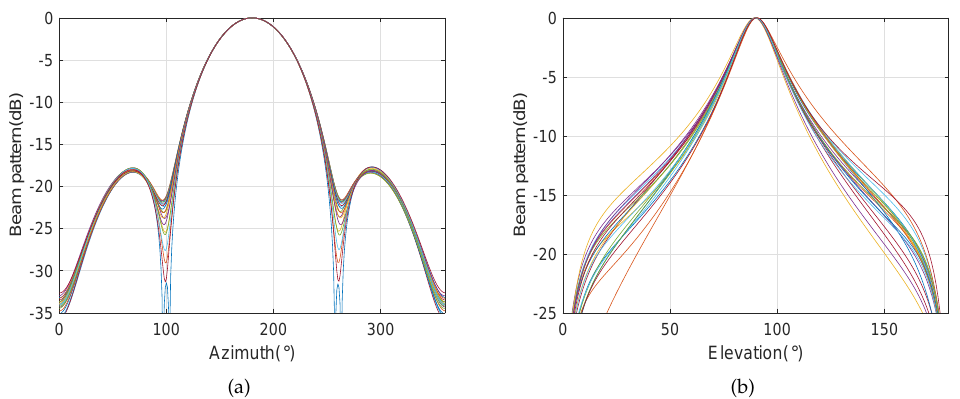
Figure 17. The beampatterns on the azimuth and elevation planes, where SNR is equal to − 5dB. ( a ) Beampattern on the azimuth plane; ( b ) beampattern on the elevation plane.